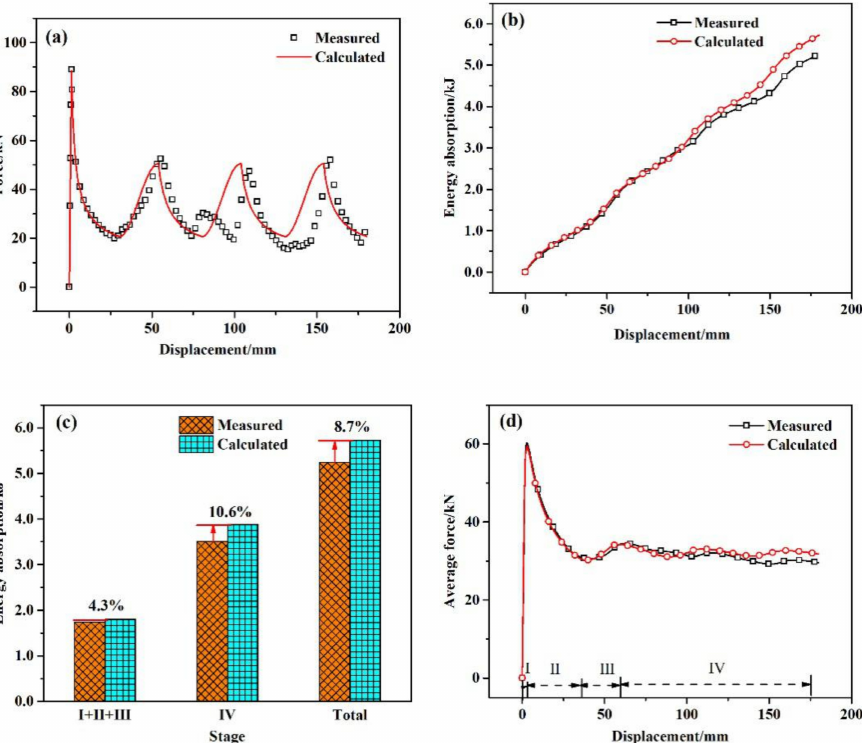
Figure 16. Verification: ( a ) crushing curve, ( b ) energy absorption curves, ( c ) energy absorption deviation, ( d ) average